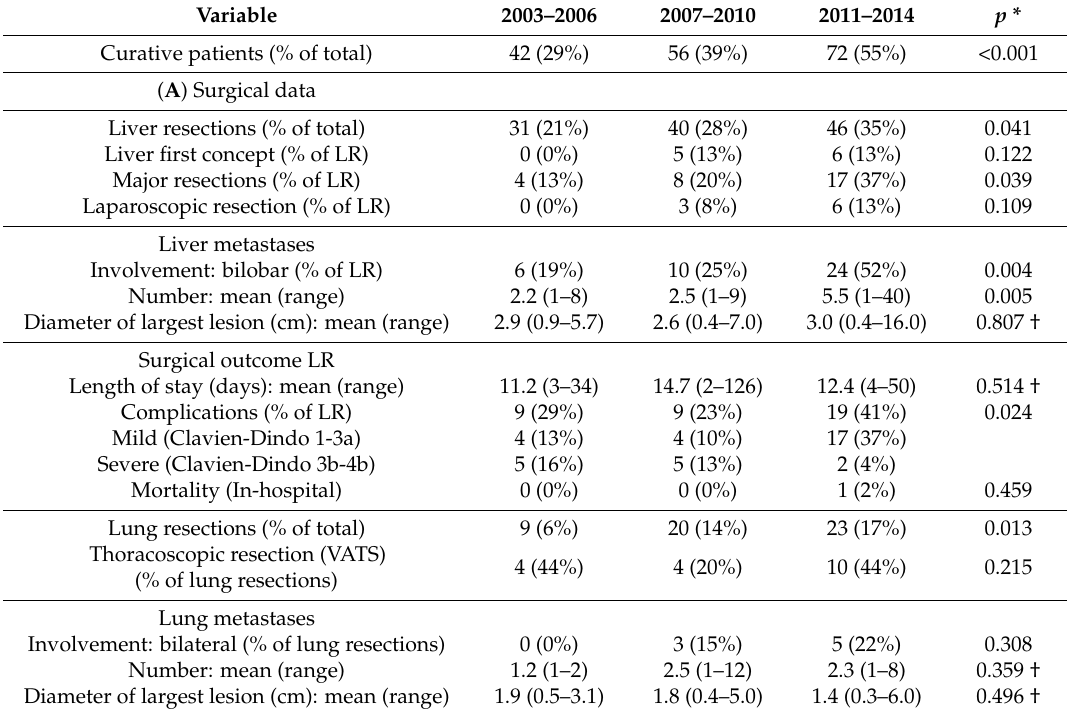
Figure 3. ( A ) Percentage of patients per period with curative-intent surgery (green) and palliative treatment (blue; p < 0.001). ( B ) Percentage of patients undergoing liver resection per period (blue = no liver resection; green = minor resection; beige = major resection ( p = 0.010). Table 3. Data on ( A ) surgical procedures and ( B ) chemotherapy for curative (CIS) patients’ group ( n = 170).